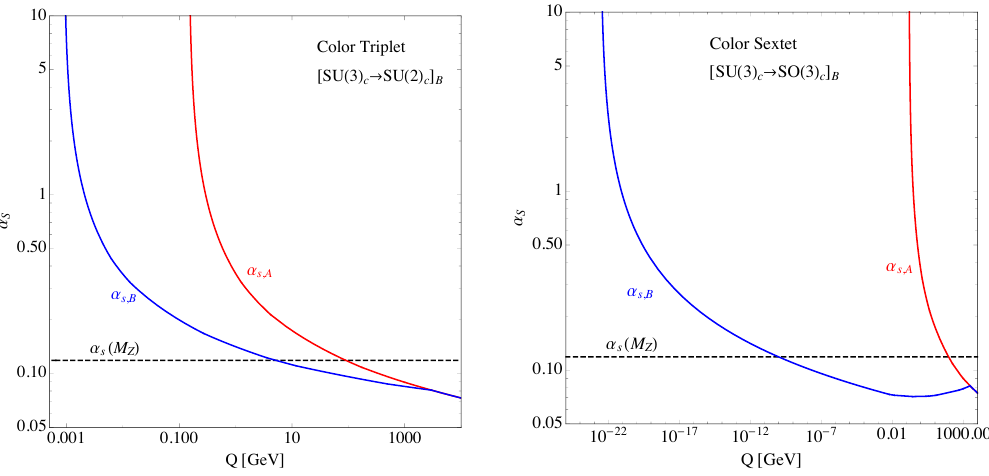
Figure 1 . Left: one-loop evolution of the strong (cid:12)ne structure constants in the visible (red) and twin (blue) sectors for a color triplet scalar with unbroken [SU(2) c ] B twin color symmetry, case I . The twin con(cid:12)nement scale is of order MeV. Right: same plot for color sextet scalar with unbroken [SO(3) c ] B twin color symmetry, case III . The twin con(cid:12)nement scale is of order 10 (cid:0) 23 GeV. In both plots we (cid:12)x (cid:11) A ( m Z ) = 0 : 1179, f (cid:8) = 3 TeV, and assume pNGB colored scalars have 1 TeV masses. s Visible and twin sector gauge couplings are matched at Q = f (cid:8)